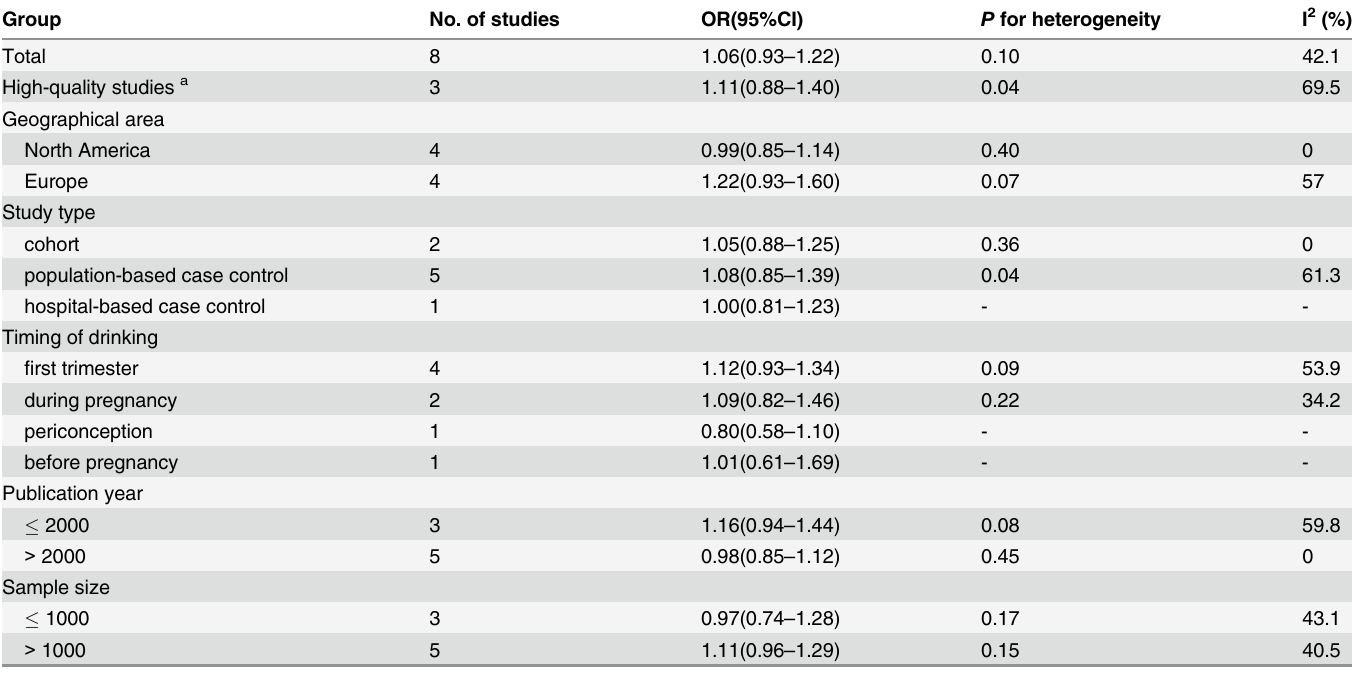
Table 1. Summary results of the association between prenatal alcohol exposure and overall congenital heart defects risk.